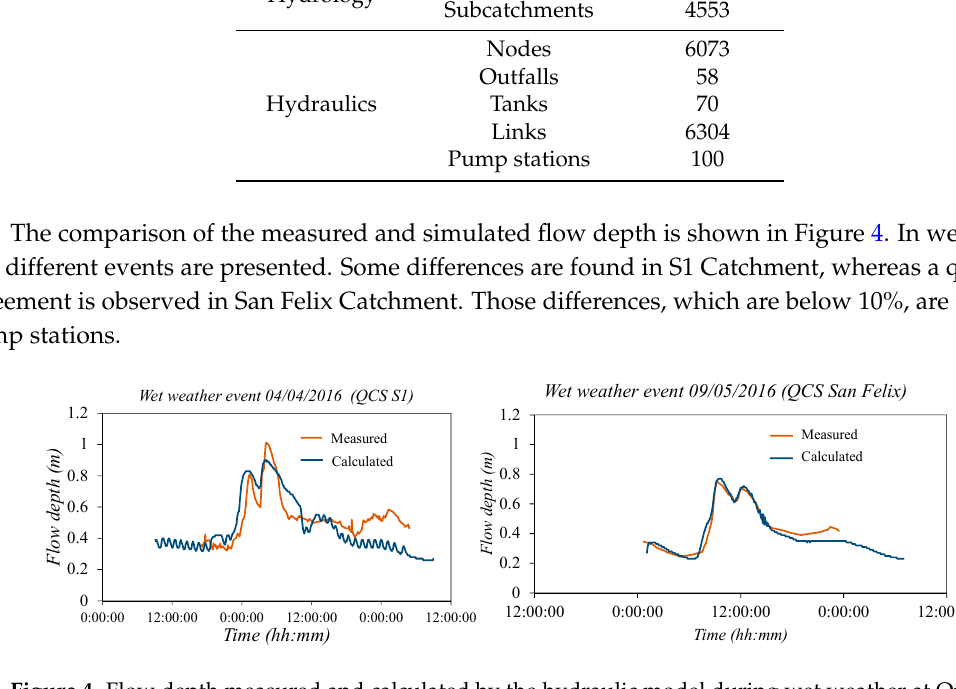
Figure 4. Flow depth measured and calculated by the hydraulic model during wet weather at Quality Control Stations S1 and San Felix.